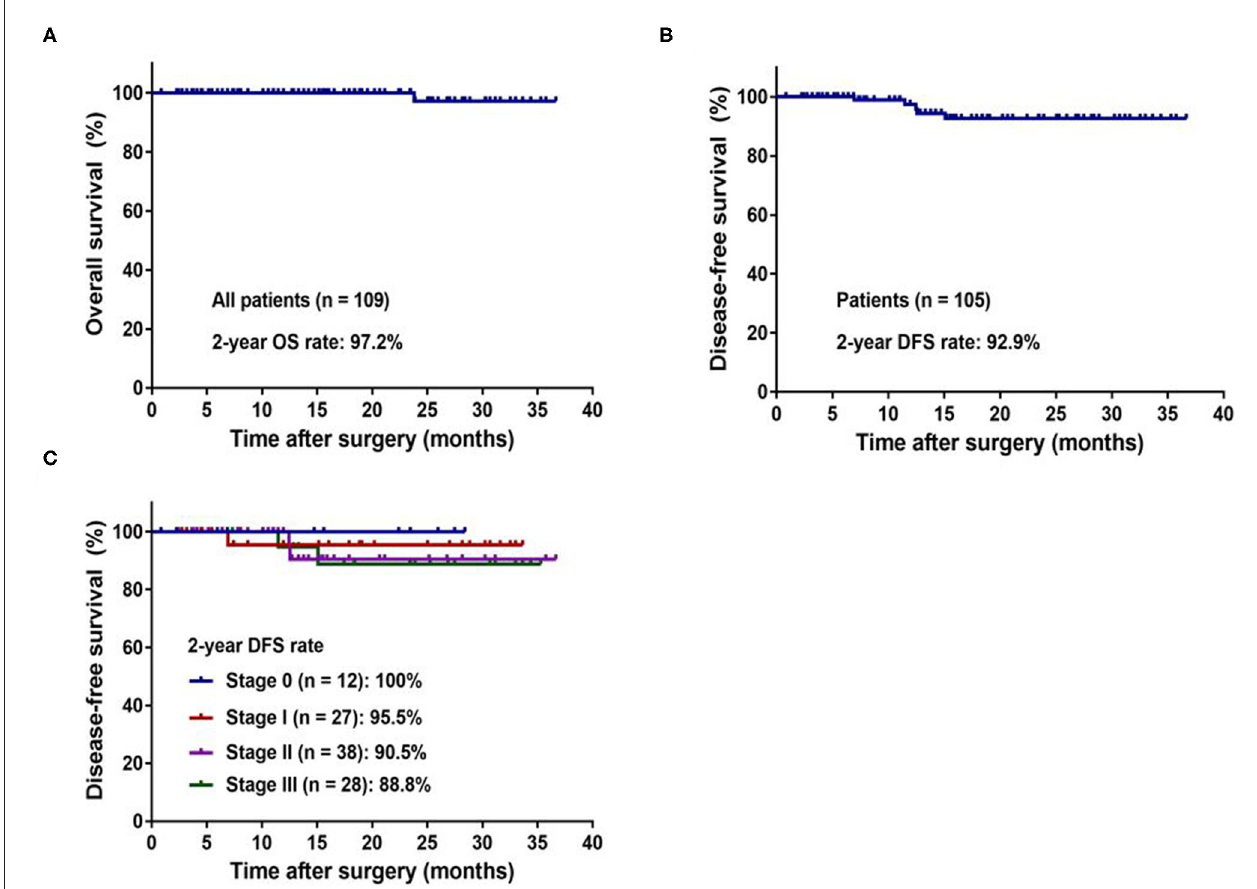
FIGURE 3 | Kaplan–Meier curves of the patients with colorectal cancer underwent robotic surgery. (A) 2-year overall survival for whole study population. (B) 2-year disease-free survival for non-metastatic patients. (C) 2-year disease-free survival by pathologic